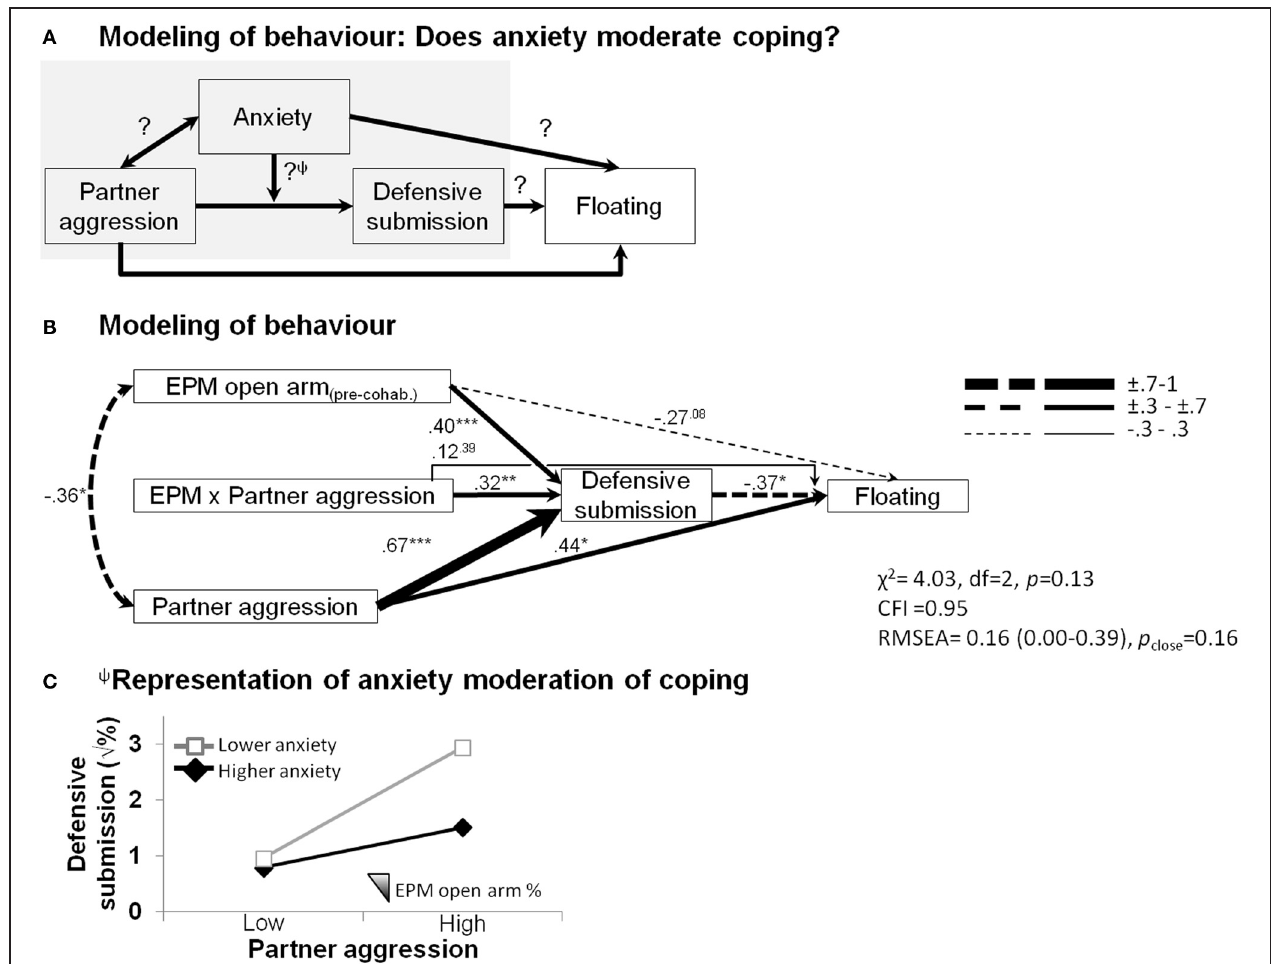
FIGURE 4 | Structural equation modeling of behaviors of each partner predicting female depressive-like outcome. Anxiety moderates the impact of partner aggression on the development of depressive-like floating behavior. (A) Integration of the behavioral patterns using structural equation modeling. Note that the result of the moderation analysis (cid:2) is graphically presented in (C) . (B) Partner aggression (1) predicted more floating, a depressive-like outcome; (2) significantly covaried with the female propensity to explore the open arms of the elevated plus-maze, as observed before the onset of the cohabitation; (3) accounted for a substantial proportion of the defensive-submissive response of the female; (4) prolonged floating was associated with less sustained defensive-submissive behaviors; and (5) the